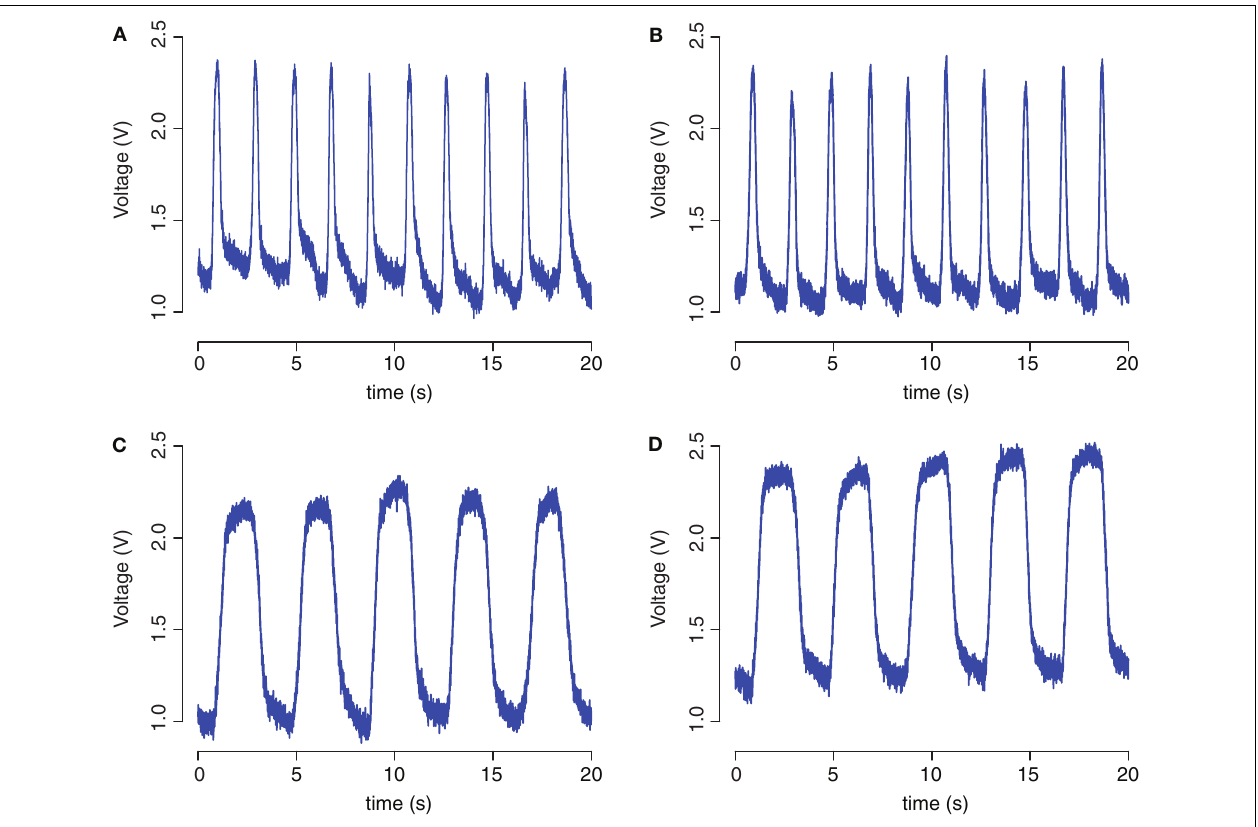
FIGURE 5 | Bend sensor recordings during manual movements. Recordings were performed outside the magnet room (A,C) and inside the magnet (B,D) with a frequency of approximately 0.5 Hz (A,B) and 0.25 Hz (C,D) .